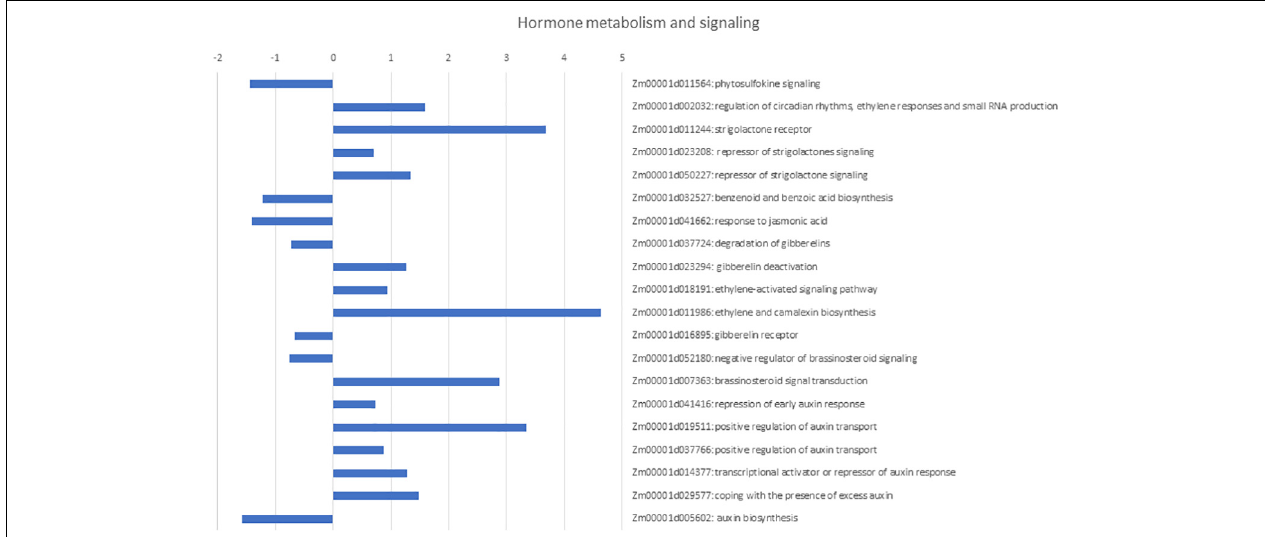
FIGURE 2 | Expression Log 2 fold change between inbred bulks resistant and susceptible to Fusarium ear rot and kernel contamination with fumonisins for differentially expressed genes (DEGs) related to hormone metabolism and